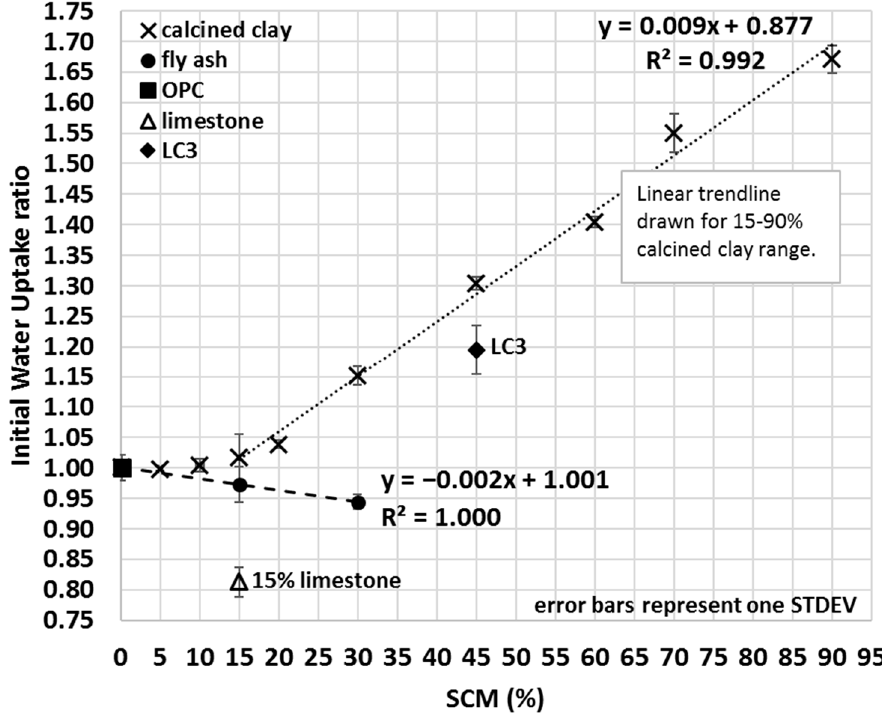
Figure 8. Average initial water uptake ratios of OPC, limestone, LC3 and various fly ash and cal- clay cined clay blends.